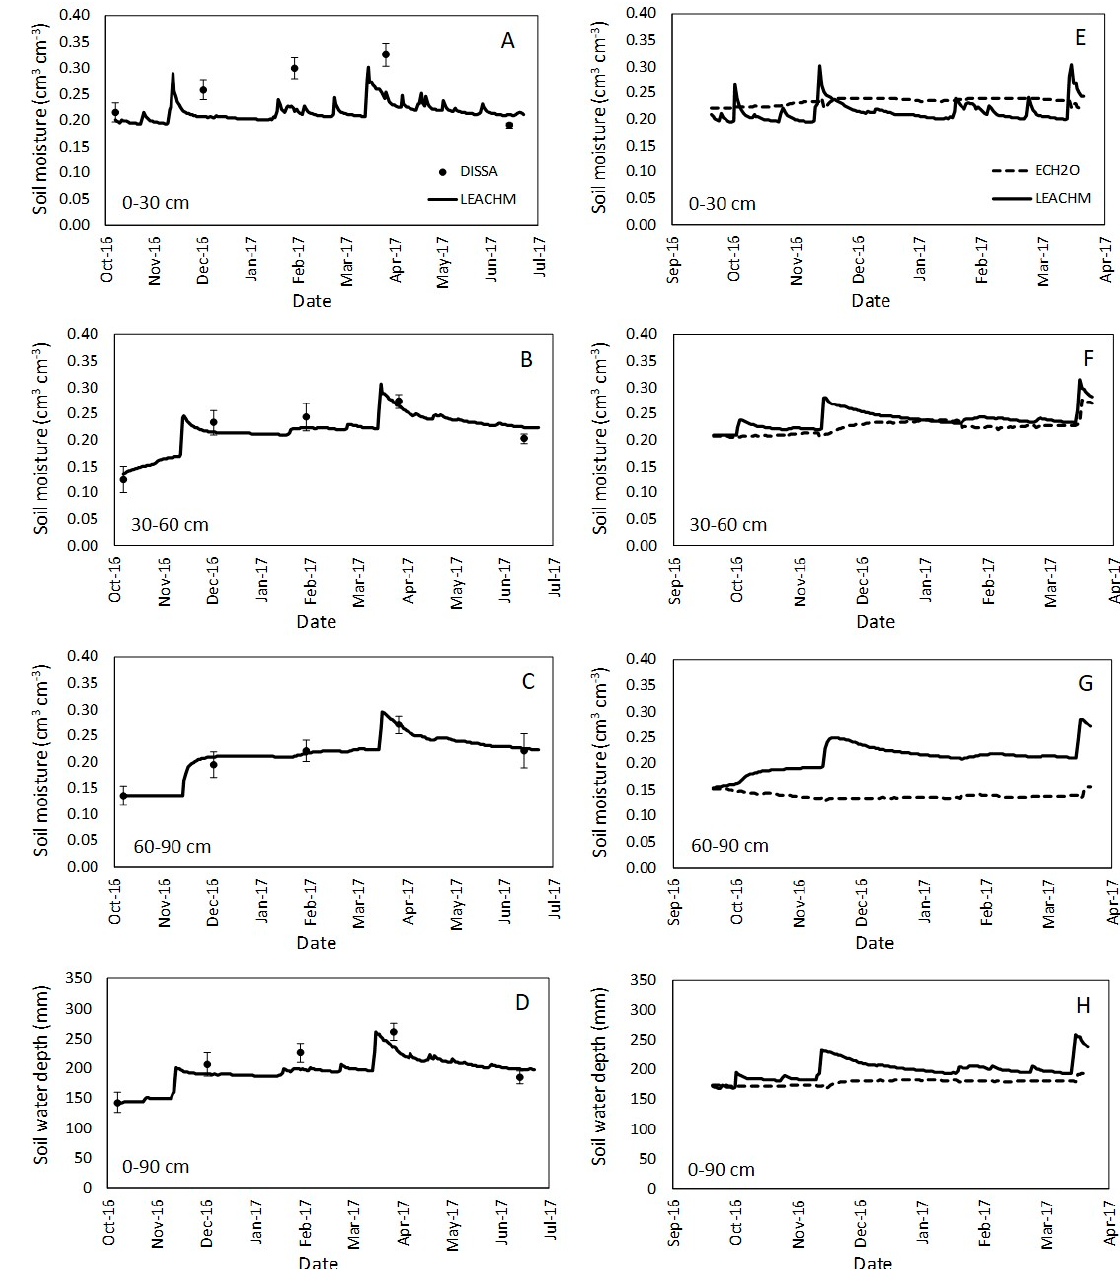
Figure 6. Soil moisture in the three soil layers ( A – C , E – G ) and soil water depth in the soil profile ( D , H ) measured from disturbed soil samples ( A – D , circles), with ECH2O sensor ( E – H , dashed line) and simulated with LEACHM (continuous line) for validation under fallow system. Vertical bars represent the standard deviation.